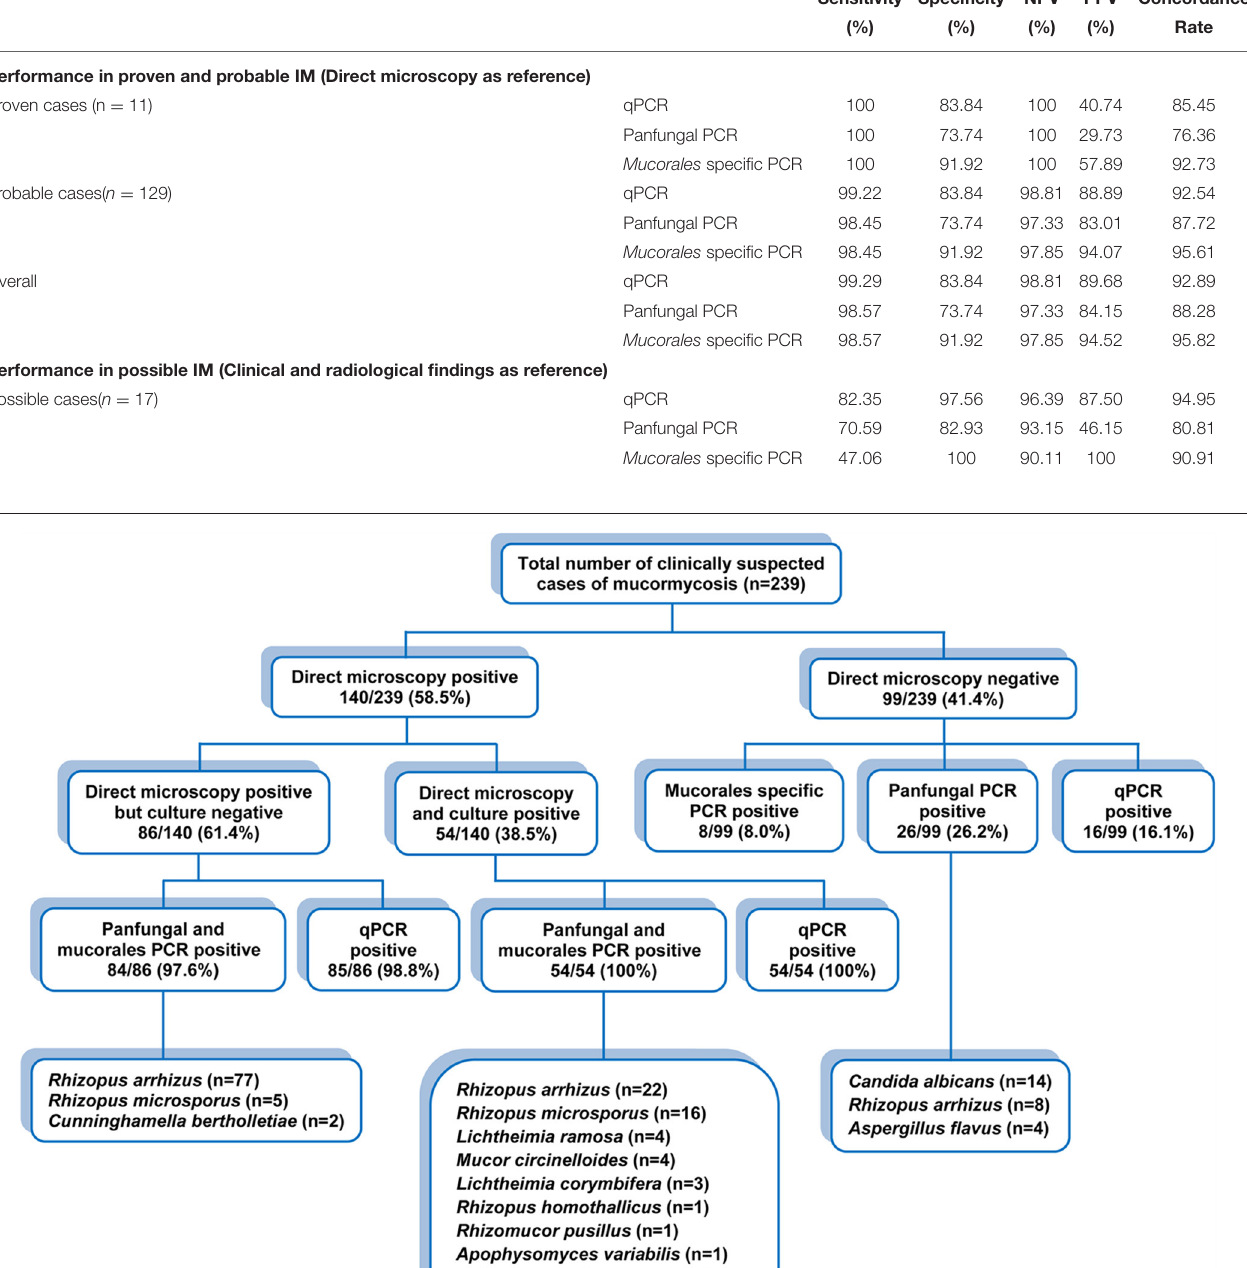
TABLE 3 | Diagnostic performance of molecular techniques in diagnosis of IM.